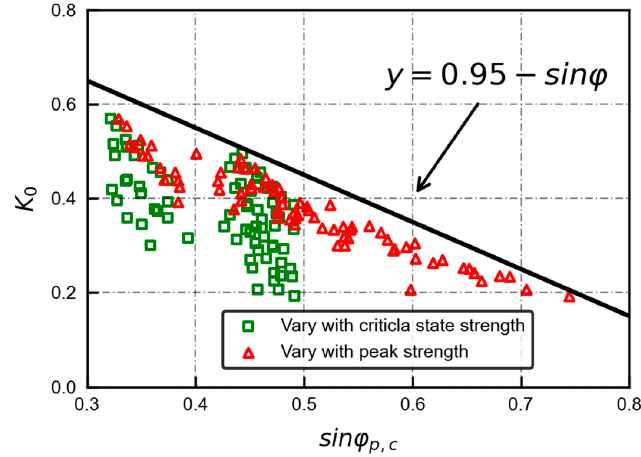
Figure 15. The relationship between K 0 and sin φ c & sin φ p .